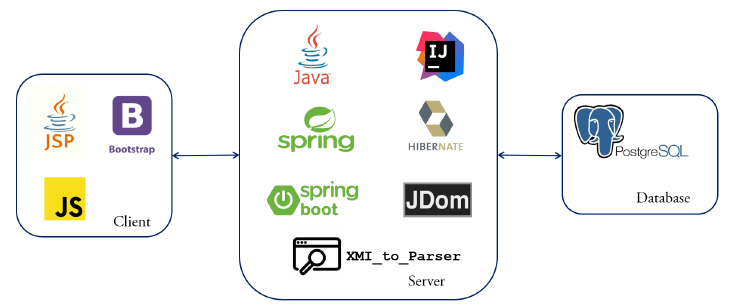
Figure 14. The mosaic of the used software